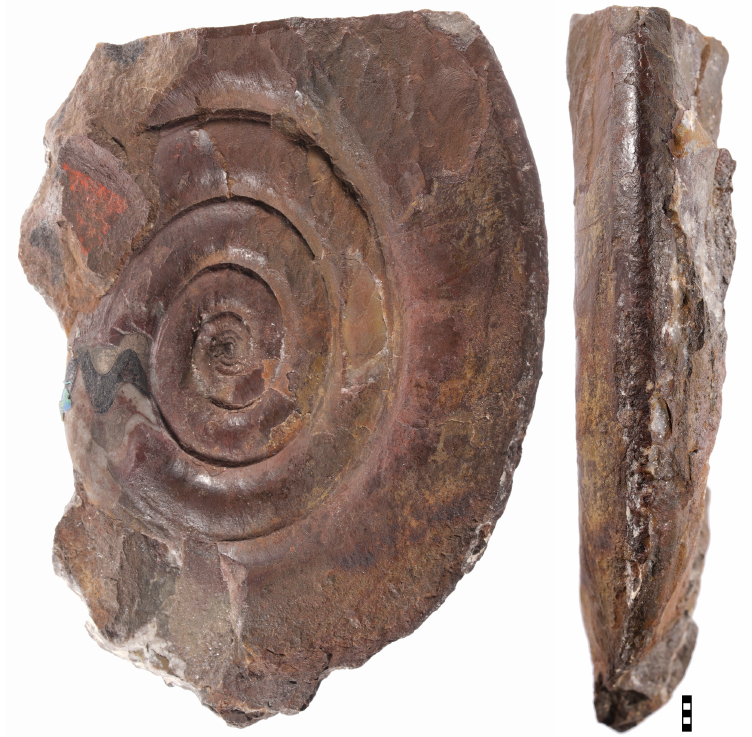
Fig. 10. Ponticeras aequabile (Beyrich, 1837); specimen GZG 389-82 from Langenaubach; the specimen erroneously proposed as neotype by House in House & Ziegler (1977). Scale bar units =